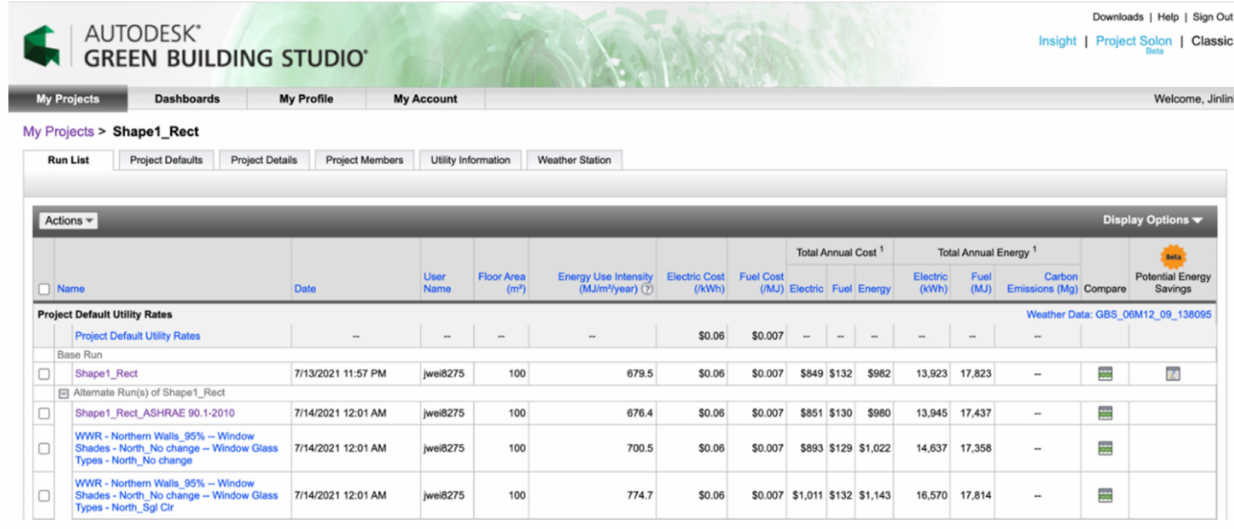
Figure 6. GBS simulation results.